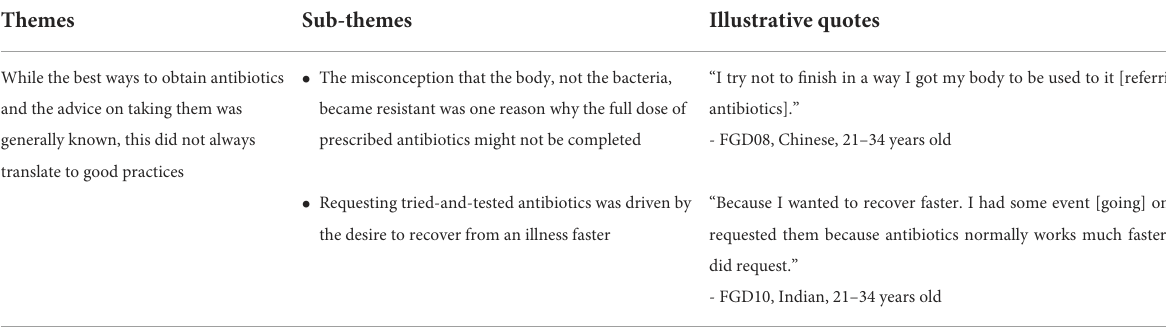
TABLE 1B Intentions and behavioral follow-through, themes collated from focus group discussion